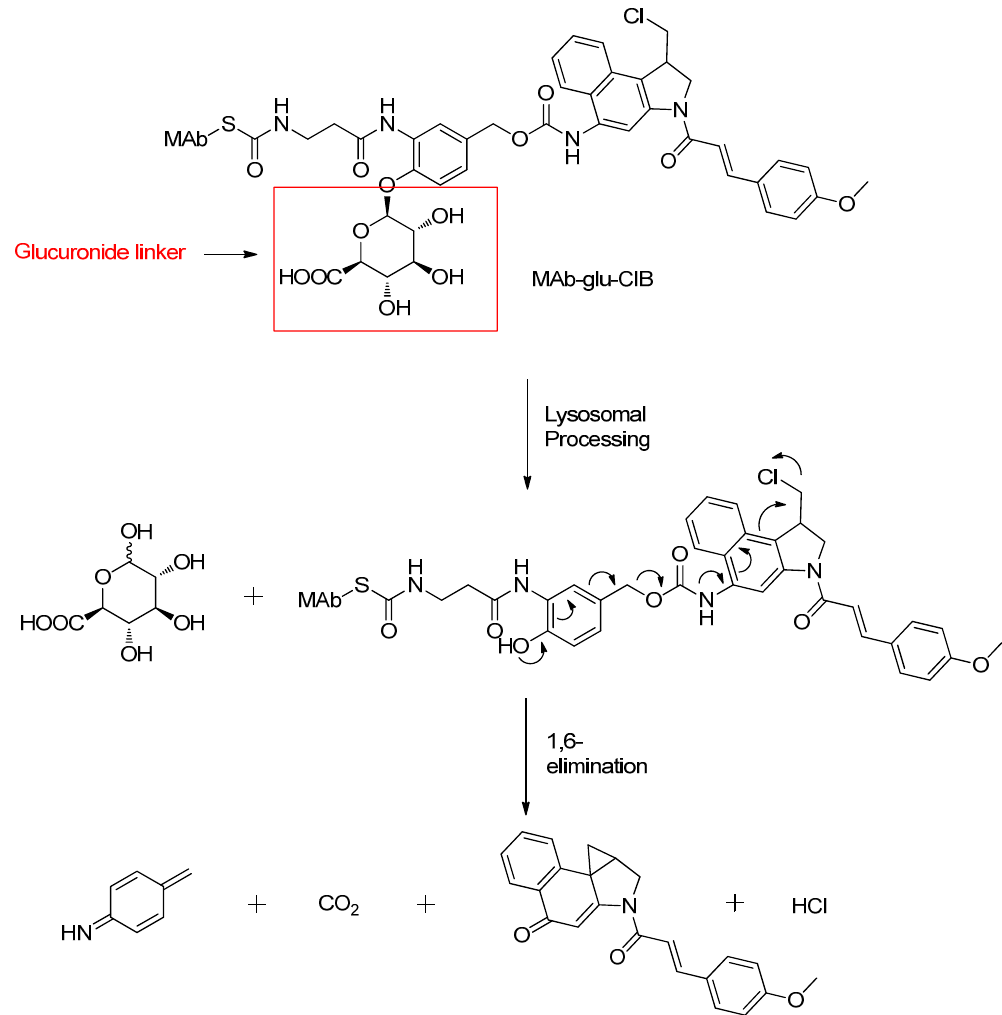
Figure 12. The structural formula of MAb-glu-CIB and the supposed cleavage mechanism after internalization into the lysosome. Adapted from reference [83].